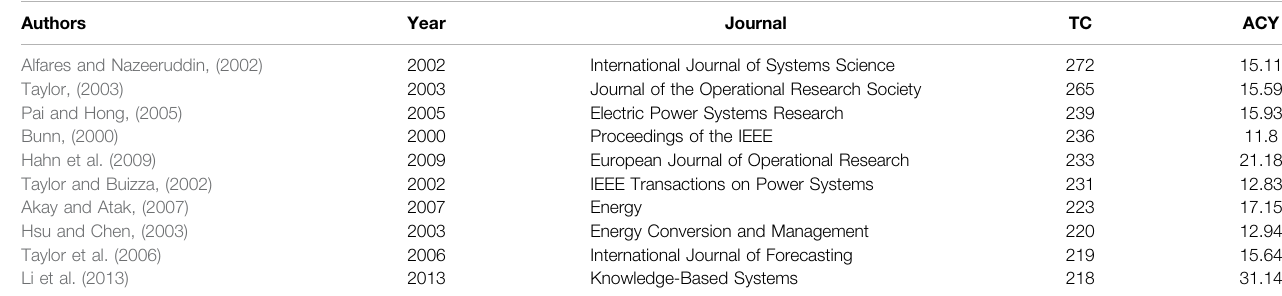
TABLE 4 | Highly cited publications in electricity demand forecasting.